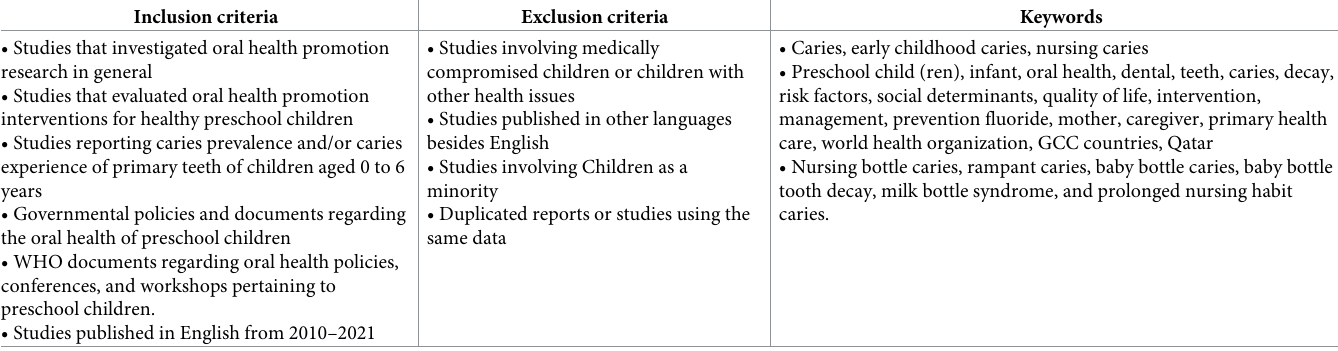
Table 1. Inclusion and exclusion criteria and keywords for the literature search. Inclusion